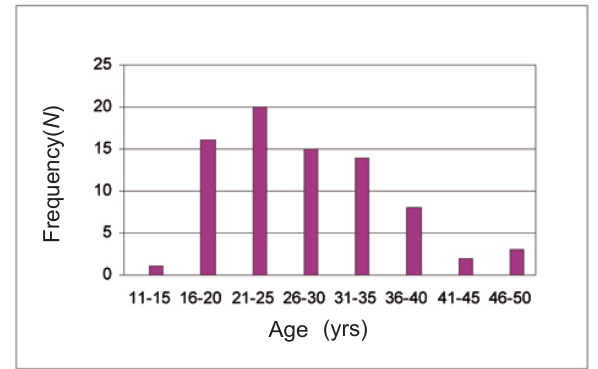
Fig. 1. Age distribution.